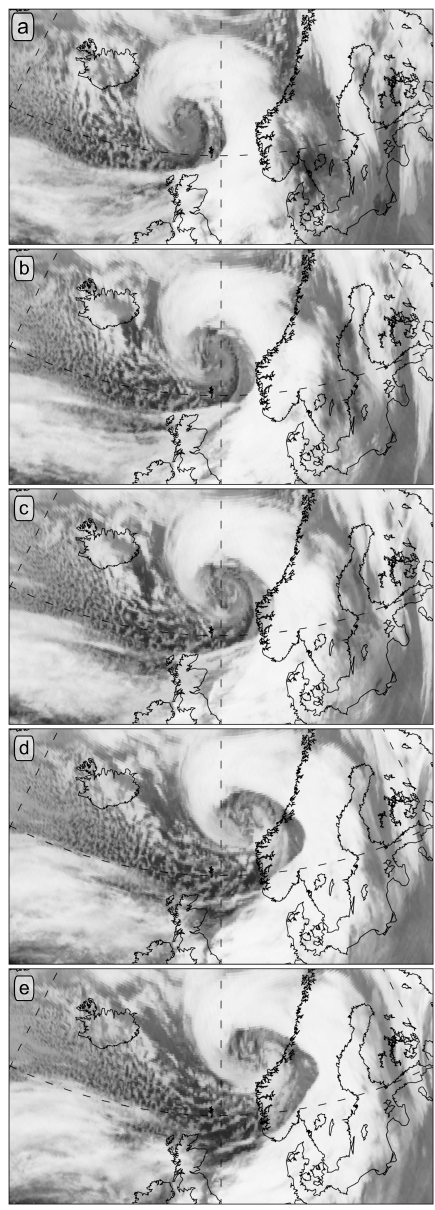
Figure 5. Remapped infrared imagery (10.8µm wavelength, Wm − 2 sr − 1 ) from Meteosat-4 covering the landfall of the New Year’s Day Storm from (a) 01:30UTC through (e) 07:30UTC on 1 January 1992 in 1.5h intervals. Imagery © EUMETSAT